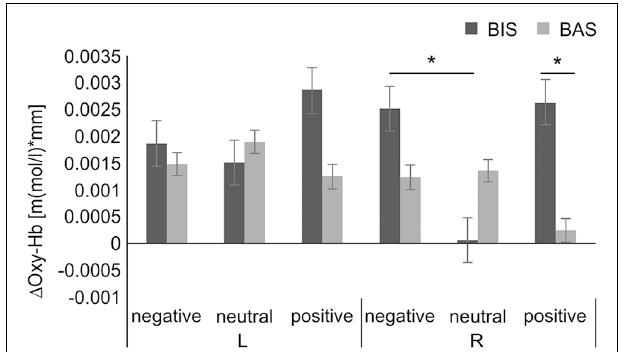
FIGURE 5 | ∆ Oxy-Hb concentration in the DLPFC during the dual 2-back task. There was a significant group × emotional valence interaction. The post hoc test showed significantly higher ∆ Oxy-Hb concentration in the right DLPFC in the negative compared with the neutral valence condition in the BIS group and significantly higher ∆ Oxy-Hb concentration in the right DLPFC in the BIS compared with BAS group in the positive valence condition. * p < 0.01. Error bars indicate the standard error. DLPFC, dorsolateral prefrontal cortex; ∆ Oxy-Hb, difference in oxygenated hemoglobin; BIS, behavioral inhibition system; BAS, behavioral activation